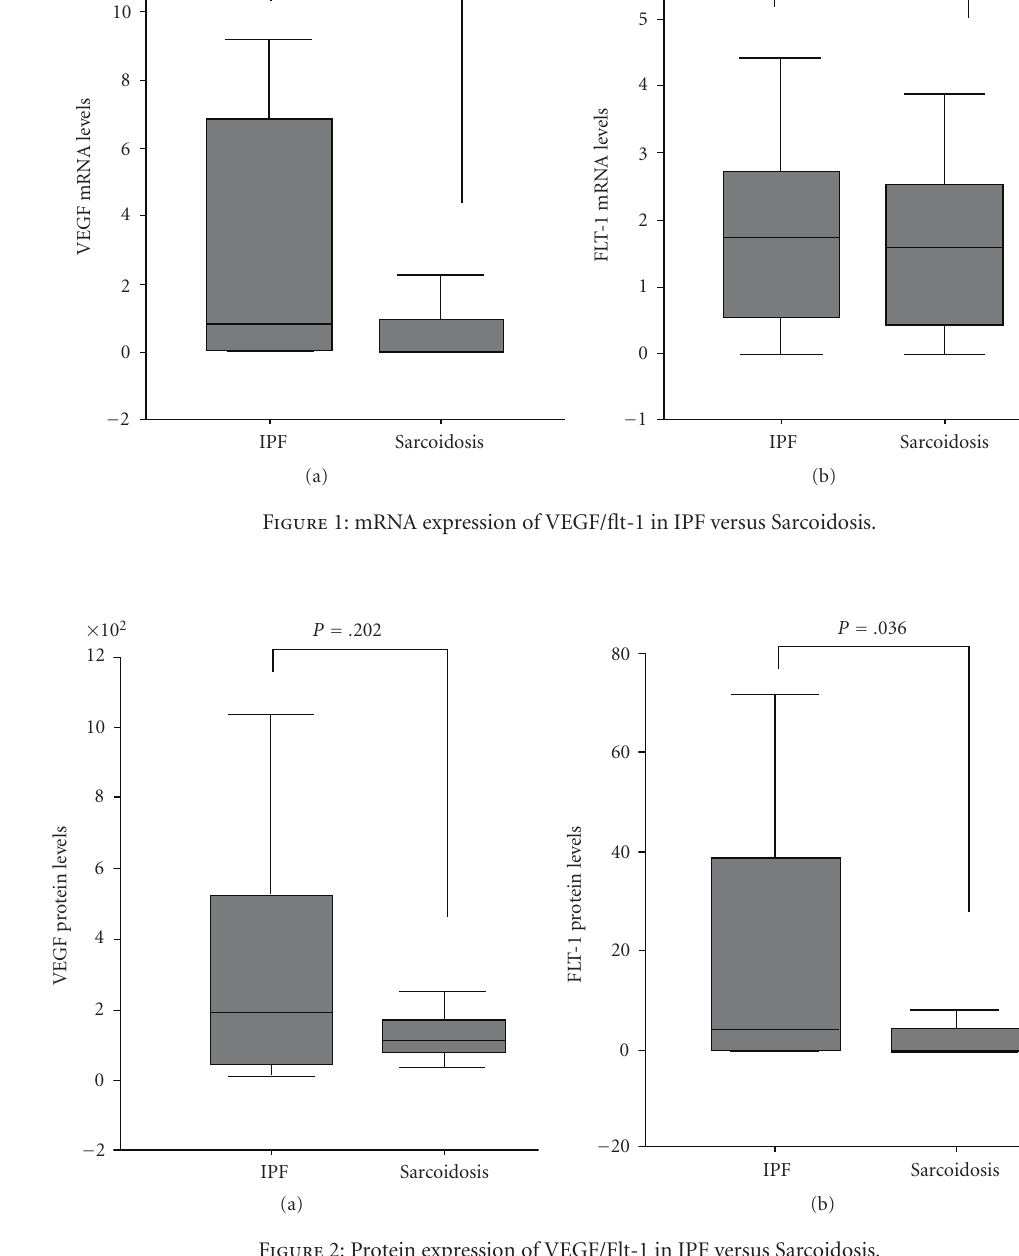
Figure 2: Protein expression of VEGF/Flt-1 in IPF versus